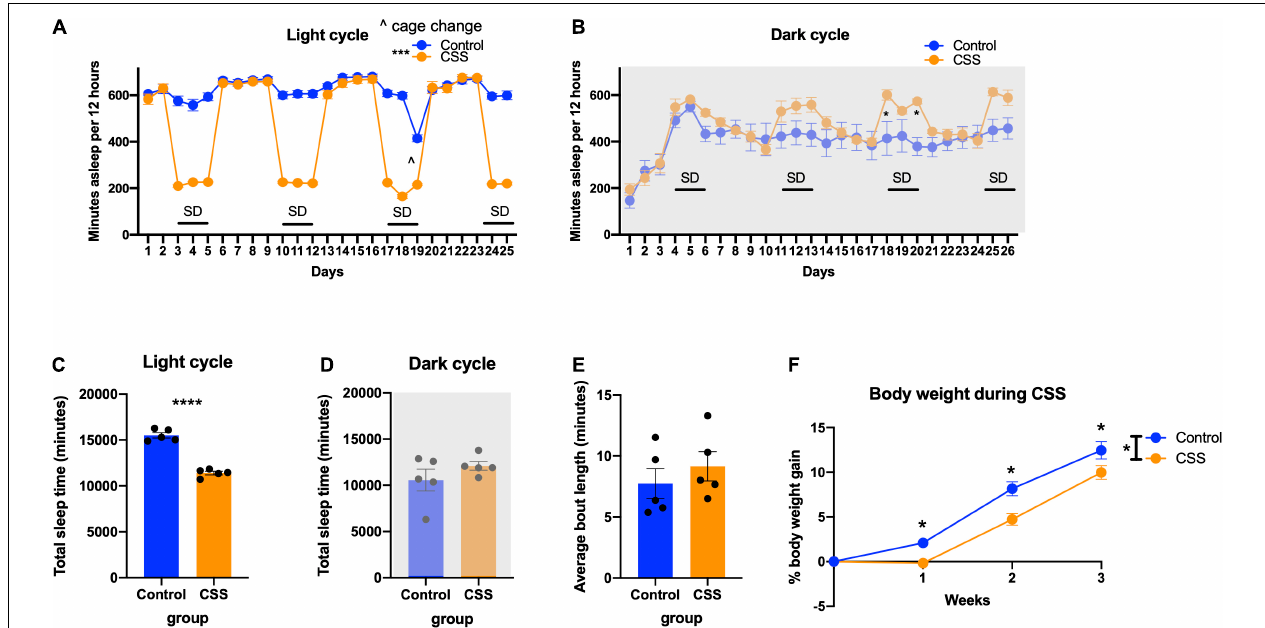
FIGURE 2 | (A) Time sleeping per 12 h during the light (inactive) cycle each day during sleep deprivation. *** indicates p < 0.001. (B) Time sleeping per 12 h during the dark (active) cycle. * indicates p < 0.05 in Tukey’s post-hoc test. (C) Total time sleeping across the duration of the experiment in the light cycle. **** indicates p < 0.0001. (D) Total time sleeping across the duration of the experiment in the dark cycle. (E) Average bout length of sleep during the 4 weeks of sleep deprivation. (F) Body weight during the weeks of sleep deprivation. * indicates p < 0.05, ∧ indicates cage change.